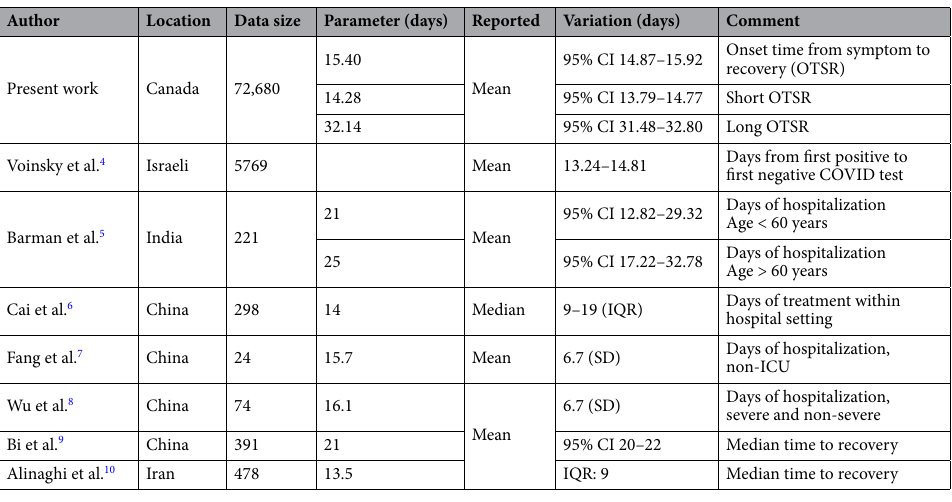
Table 1. Comparison of several studies (including the present work) for infectious period along with sample size, mean/median and ranges. Here SD and IQR stand for standard deviation and interquartile range,